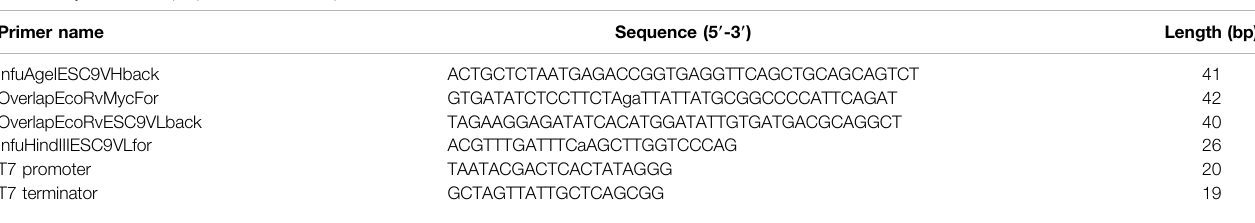
TABLE 1 | Primers for preparation of Fab expression vector.